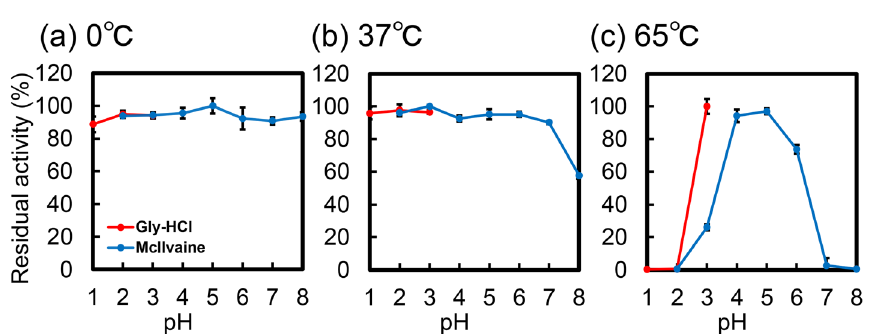
Figure 4. pH stability of Mf -CHIA. Mf -CHIA was incubated for 1 h at 0 °C, 37 °C or 65 °C in Gly-HCl buffer (pH 1.0 to 3.0), McIlvaine’s buffer (pH 2.0 to 8.0). After the pre-incubation at the indicated pH, the residual activity was measured at pH 5.0 (optimal pH condition of monkey CHIA) in McIlvaine’s buffer. Red lines, Gly-HCl buffer; blue lines, McIlvaine’s buffer. ( a ) 0 °C, ( b ) 37 °C and ( c ) 65 °C. We show the relative activity when the highest residual activity of Mf -CHIA was set to 100%. The chitinolytic activities are expressed with the subtraction of the blank experiments. Error bars represent mean ± standard deviation from a single experiment conducted in